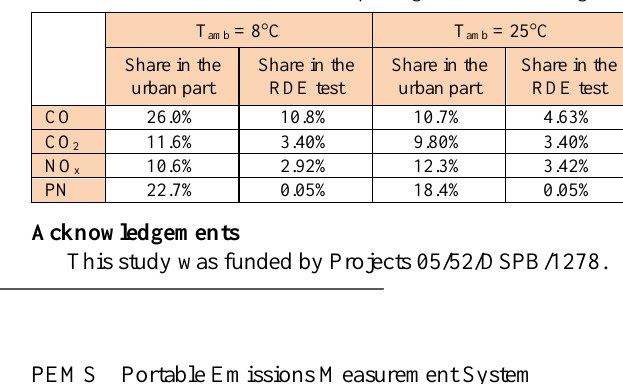
Table 2. Characteristics of the passenger car used in